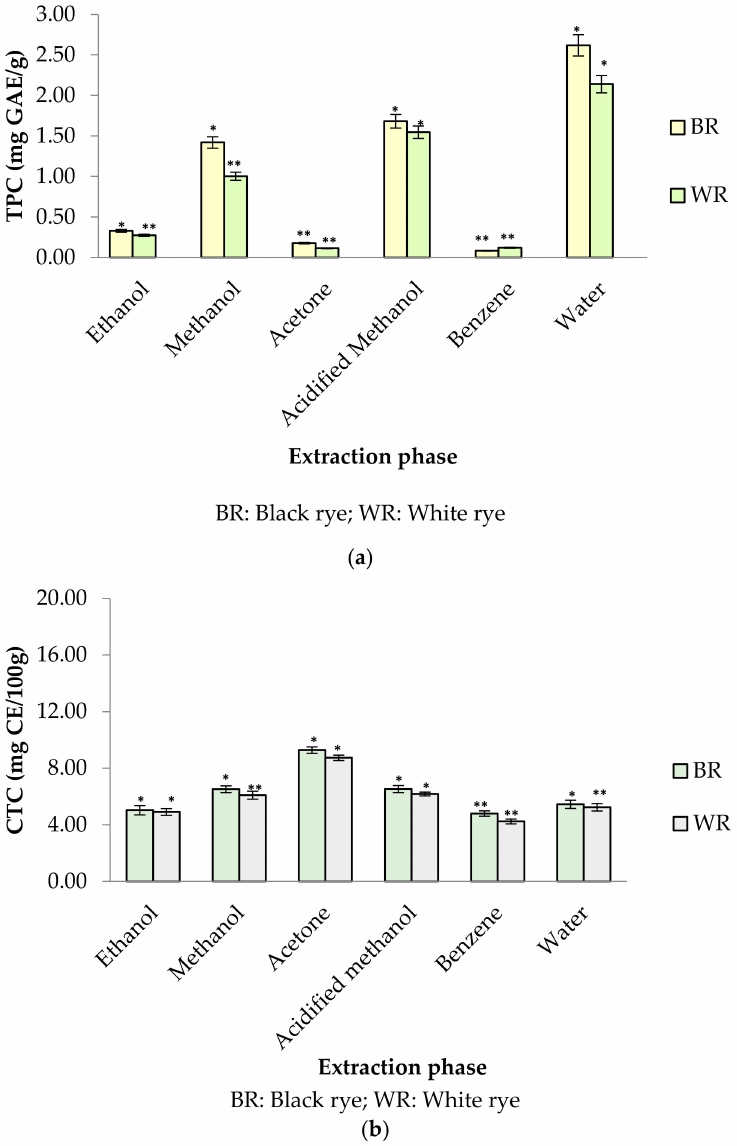
Figure 2. ( a ) TPC in different rye extracts; ( b ) CTC in different rye extracts. * significantly different at p < 0.05, ** significantly different at p <